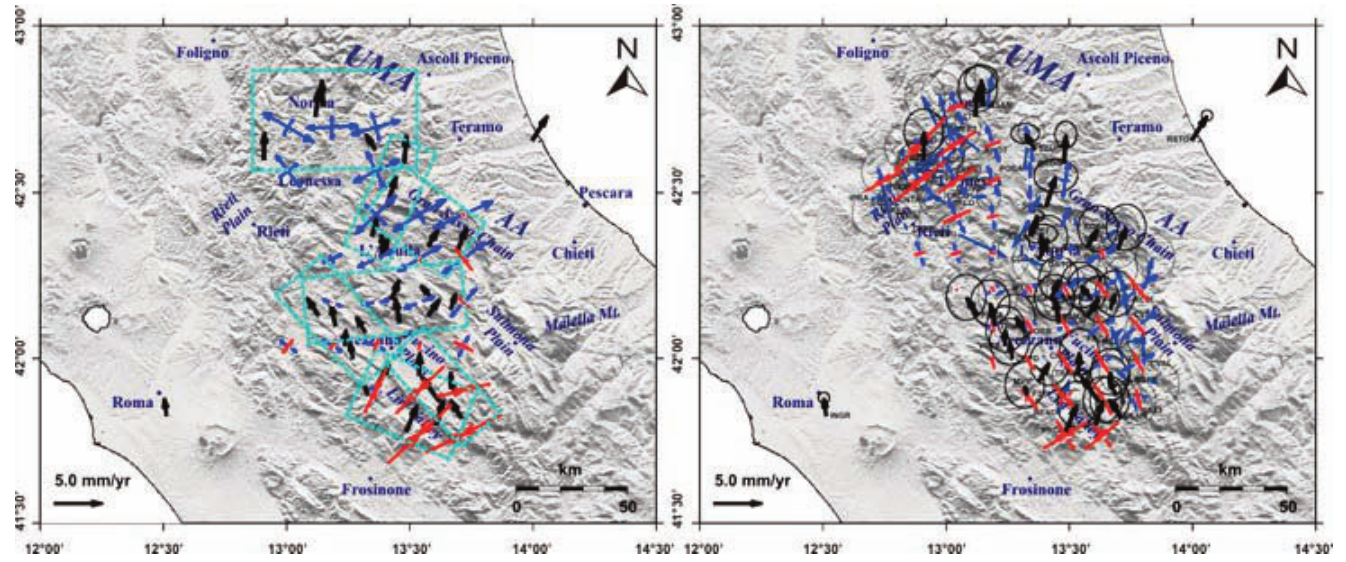
Figure 11. Left panel: velocity field obtained using the statistical method proposed, with a search radius of 20 km and the matching parameters D mm/y and D = 1.0 mm/y. Cyan blocks, sites with similar trends. The strain rate field estimated using a modified least-squares approach is also shown. Right i panel: previous velocity fields (bold black arrows) and trends (blue arrows) of the stations ruled out of the analysis, together with modified errors. Umbria- Marche Apennines (UMA) region.